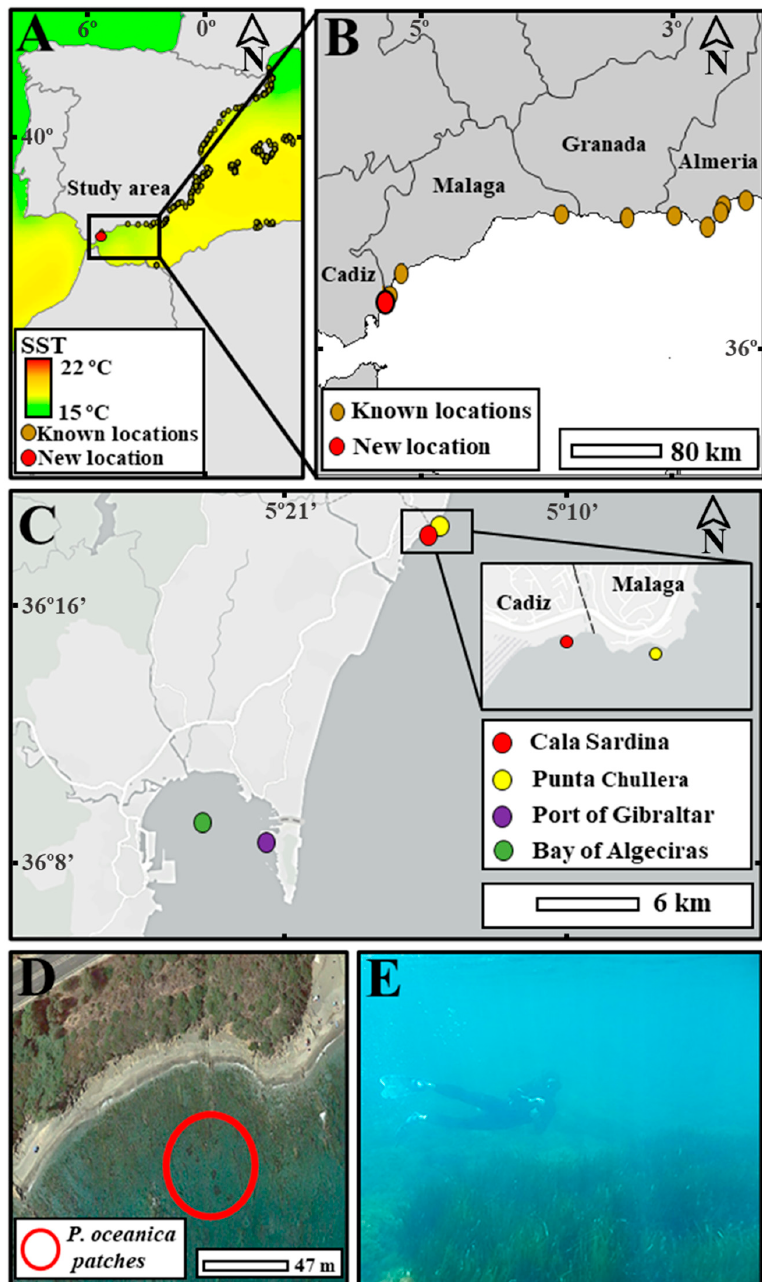
Figure 1. ( A ) Map of satellite-derived data of mean annual sea surface temperature (SST [°C]; https://www.bio-oracle.org/ (accessed on 9 May 2022)) in the Spanish Mediterranean coast and ( B ) map of the northwestern coast of the Alboran Sea showing the known locations of P. oceanica populations (brown circles) and the newly reported population (red circle). Records of known P. oceanica populations were derived from Chefaoui et al. (2017) [25]. ( C ) Map of the eastern coast of Cadiz region showing the locations of the newly documented P. oceanica meadow (red circle), the Punta Chullera’s meadow (yellow circle; Record obtained from Ruiz et al. (2015) [9]), the port of Gibraltar (purple circle) and the bay of Algeciras (green circle). ( D ) Satellite image of Cala Sardina, Cadiz (36 ◦ 18 (cid:48) 38.80 (cid:48)(cid:48) N, 5 ◦ 15 (cid:48) 15.13 (cid:48)(cid:48) W; Google Earth Pro (https://earth.google.com (accessed on 9 May 2022)) showing the newly discovered patches of P. oceanica . ( E ) A photograph of one of the new documented P. oceanica